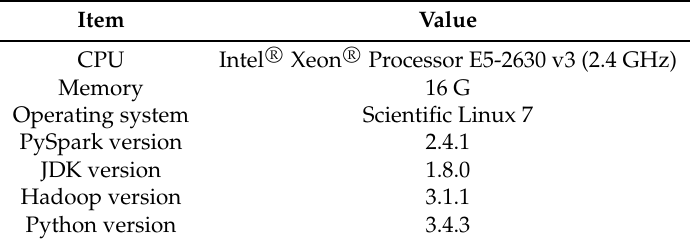
Table 2. Experimental setup (each node).